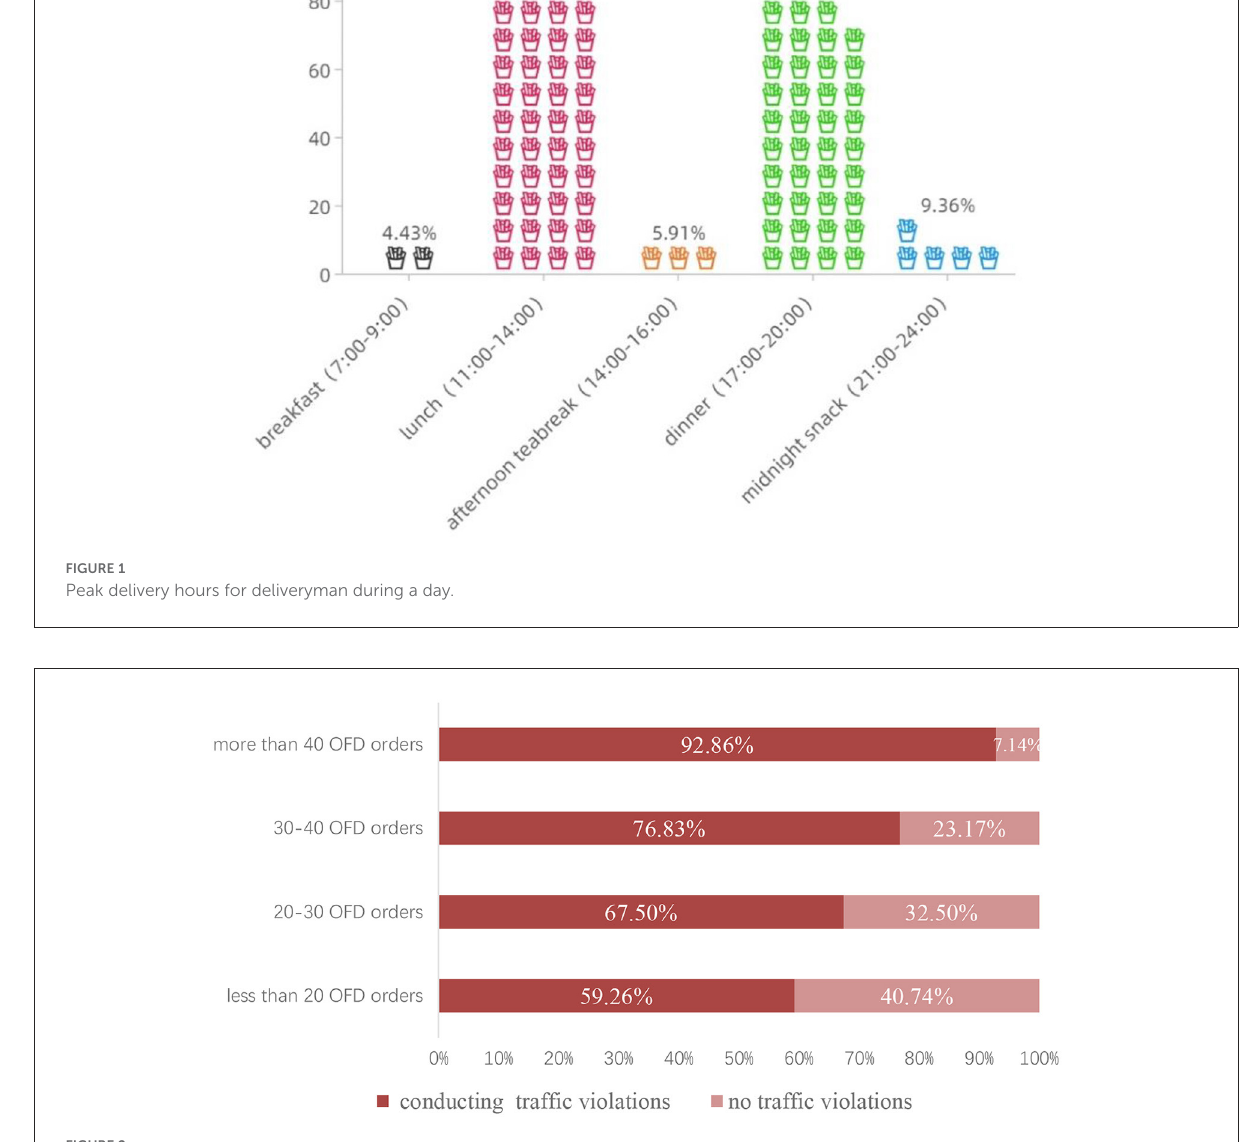
FIGURE2 Relationship between the number of OFD orders and conducting traffic violations